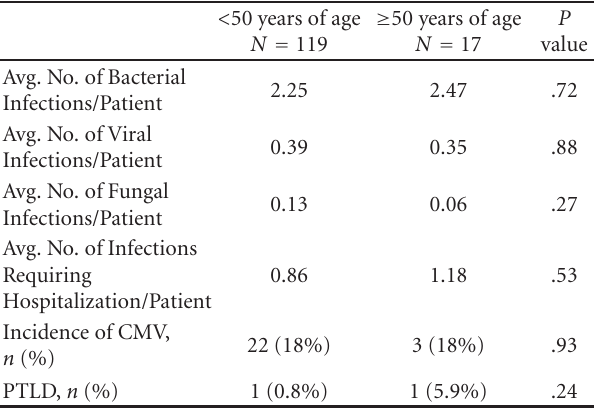
Table 4: Non-surgical infectious